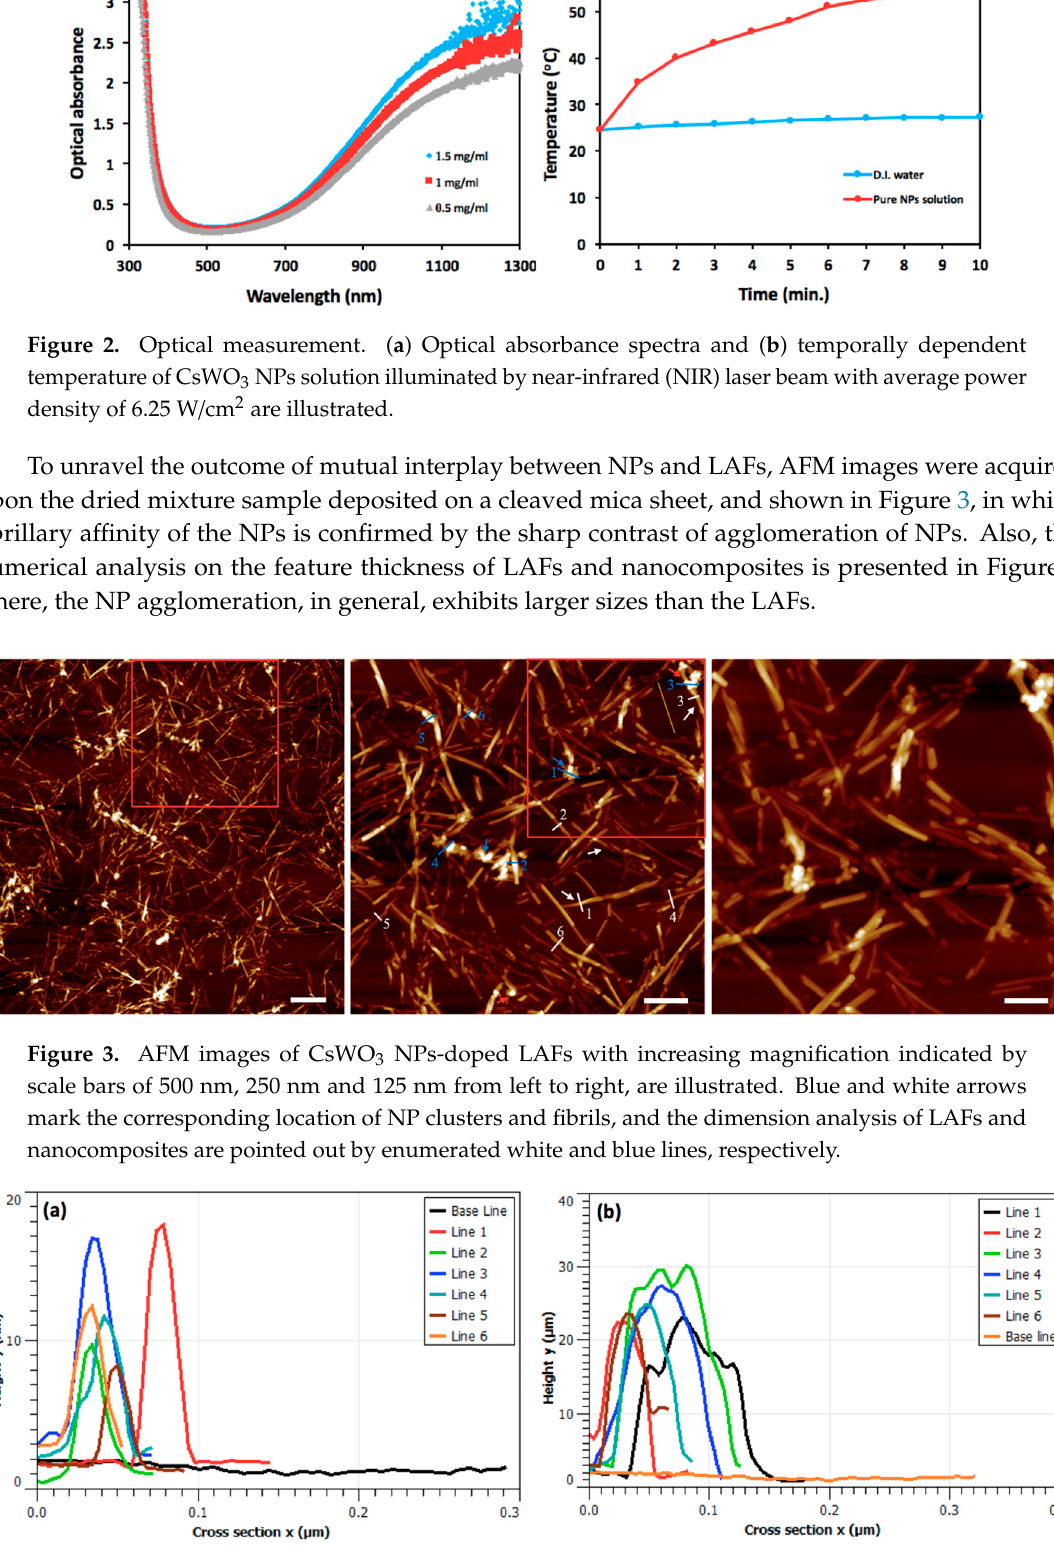
Figure 4. Dimensional analysis. Spatial profiles of height y across the surface morphologies of ( a ) LAFs and ( b ) nanocomposites indicated by the enumerated blue and red lines in Figure 3, where yellow line is the base line for both analysis, are presented.